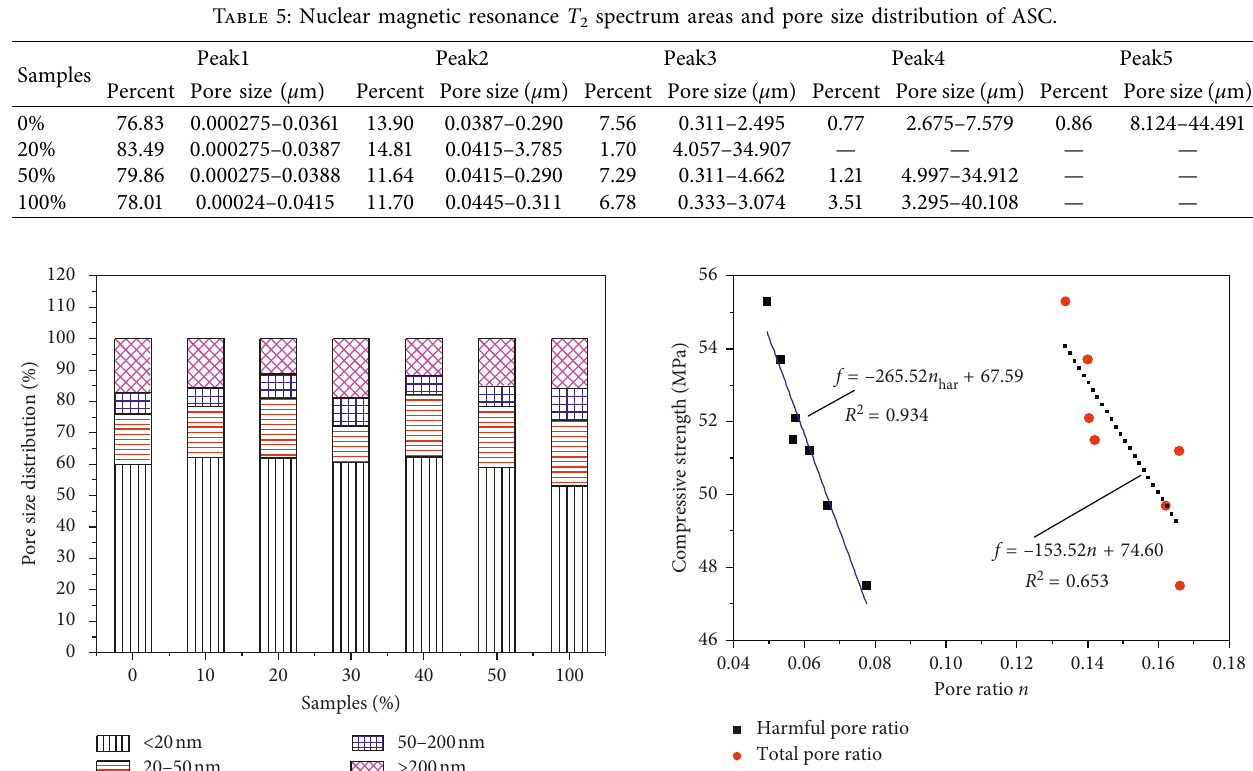
Figure 10: Relationship between compressive strength and pore